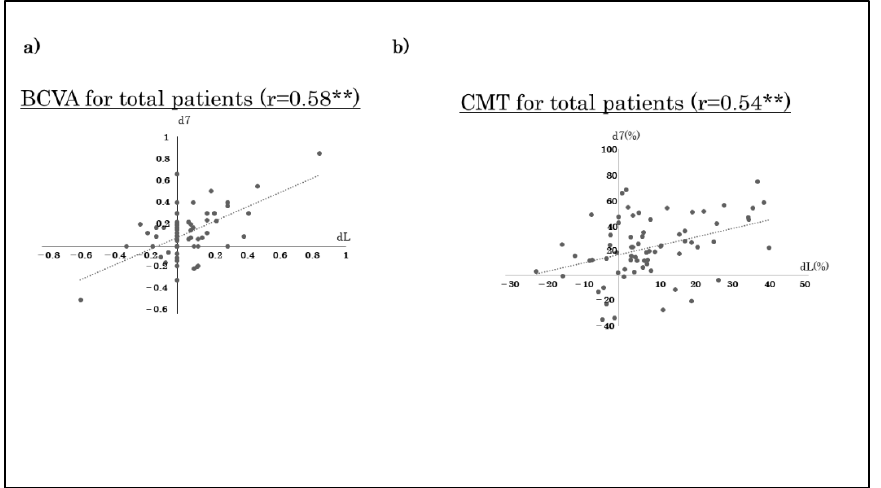
Table 2. Correlation between d7 value and dL value for BCVA and CMT.